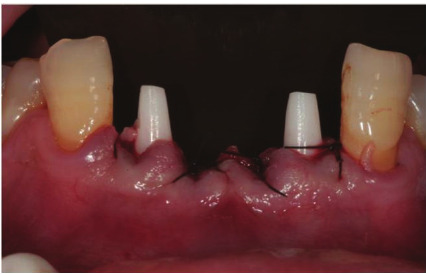
Figure 5: Two monocomponent zirconia implants are placed in the areas 3.2 and 4.2.